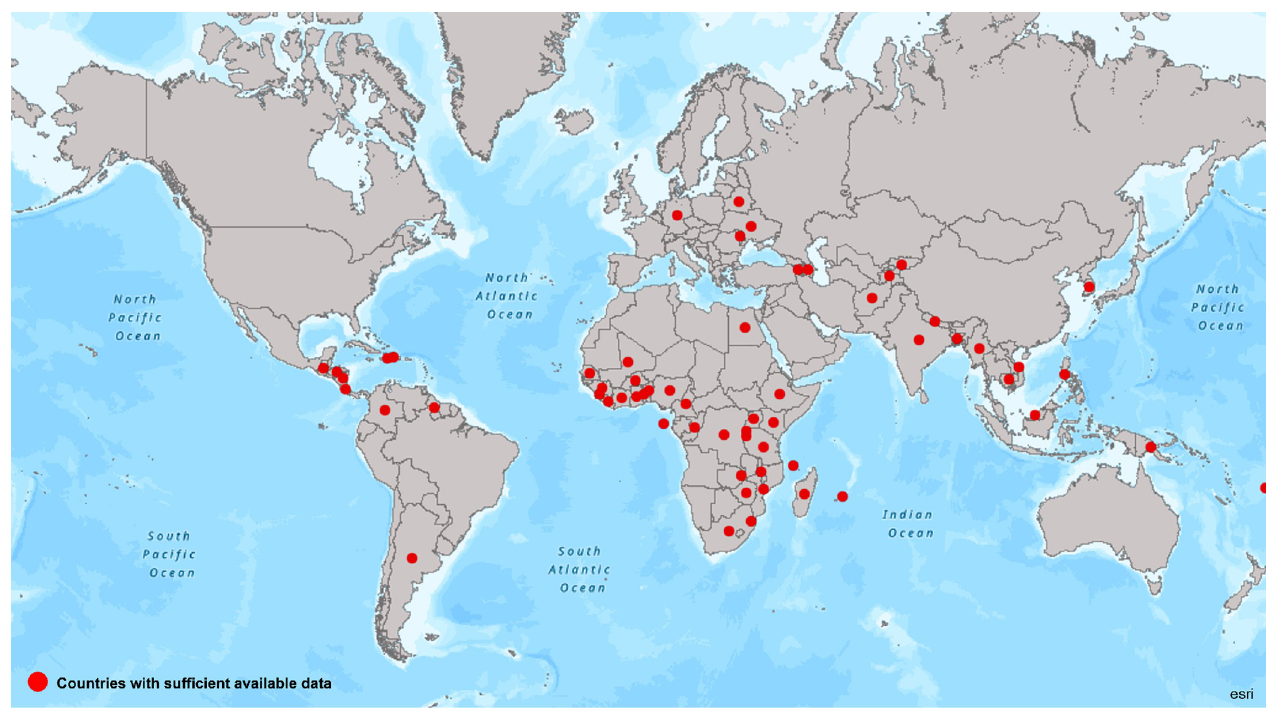
Fig 2. Countries with sufficient available data on HIV stigma indicators. Base layer of the map used are from ArcGIS, ESRI: https://arcg.is/8DHLK. � Data were available for more than 40% of indicators.